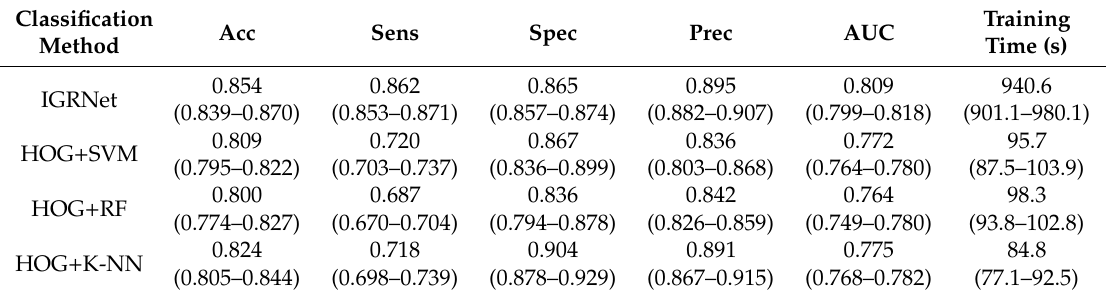
Table 6. The results of comparison with baseline algorithms. The values represent the average values of the results and their 95%